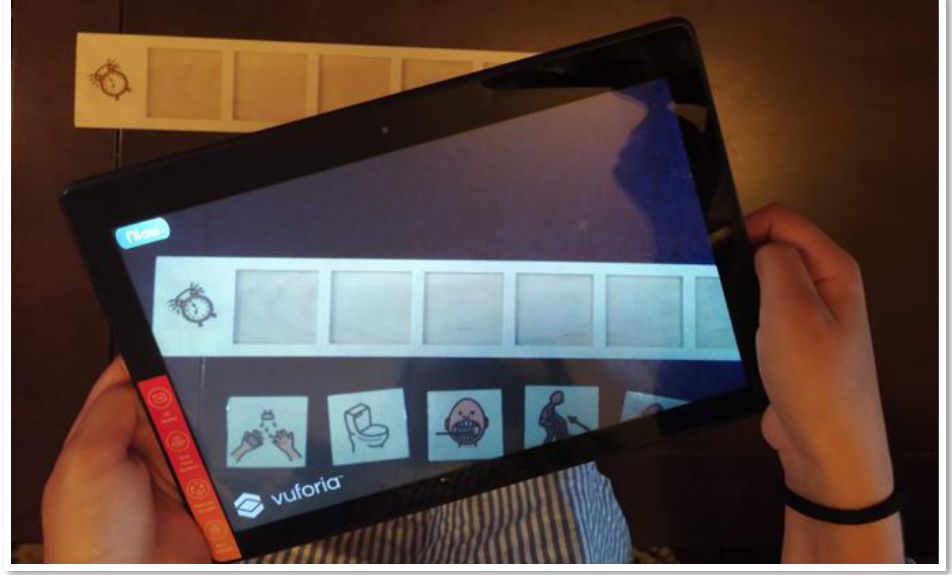
Figure 28. Shooting triggers (AR application).